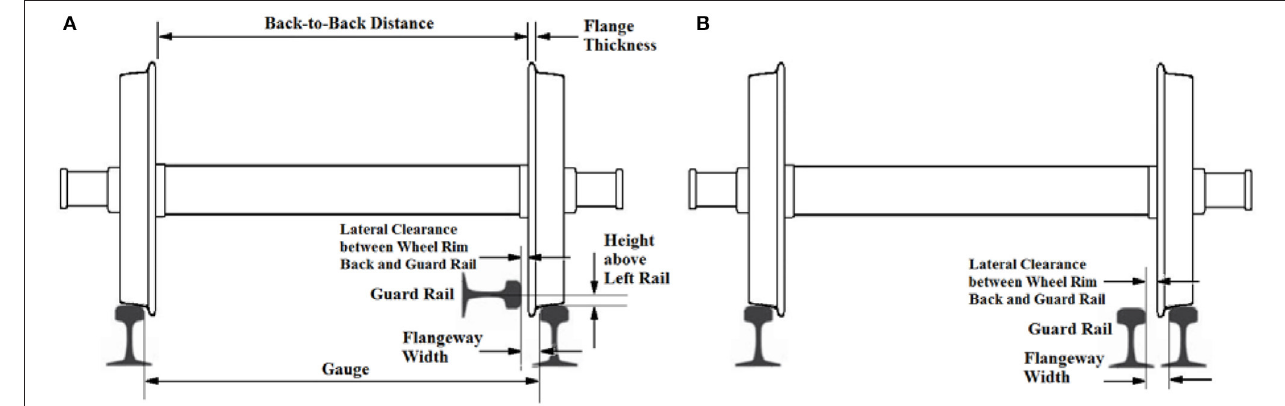
FIGURE 1 | Arrangements of guard rail.